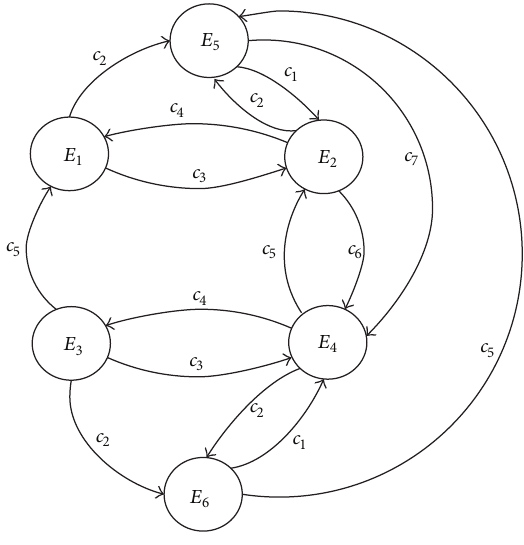
Figure 2: State transition diagram.